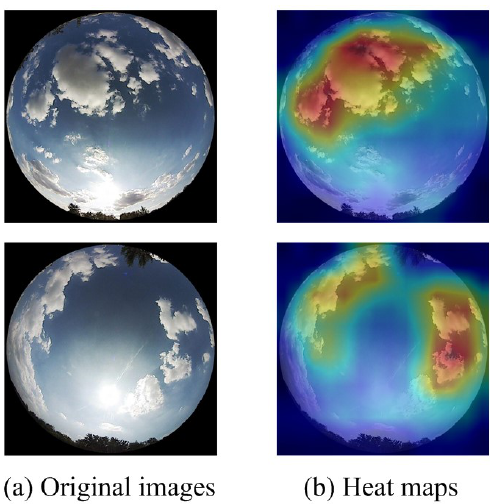
Figure 4. ( a ) represents the original ground-based cloud images and ( b ) represents the visualization features of convolutional neural networks (CNNs).